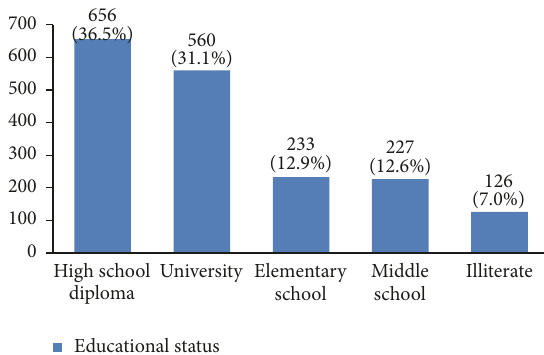
Figure 3: The educational status of the studied breast cancer cases.